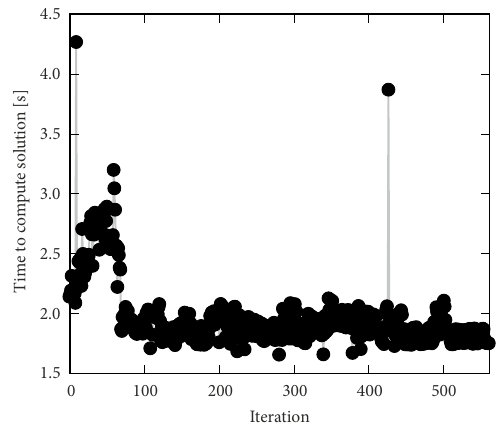
Figure 5. Time taken per iteration: static